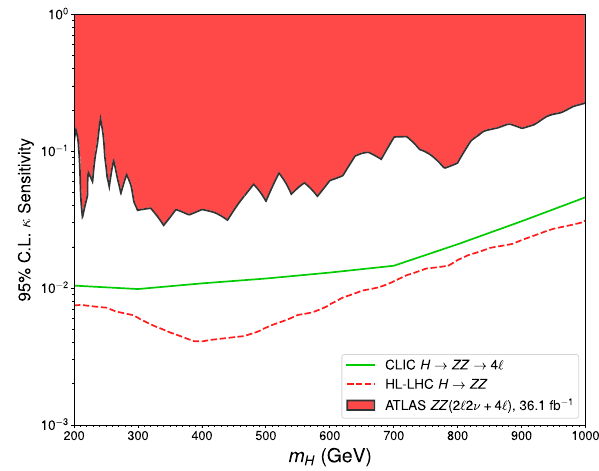
Fig. 4 95% C.L. sensitivity to κ = σ H /σ SM as a function of m H for H e + e − → H νν ( H → Z Z → 4 (cid:2) ) at 3 TeV CLIC with L = 2000fb − 1 (solid green line). Shown for comparison are the 95% C.L. excluded regionfrompresentATLAS H → Z Z searches[19](redregion)andthe projected HL-LHC (13 TeV, L = 3ab − 1 ) expected 95% C.L. exclusion sensitivity (dashed red